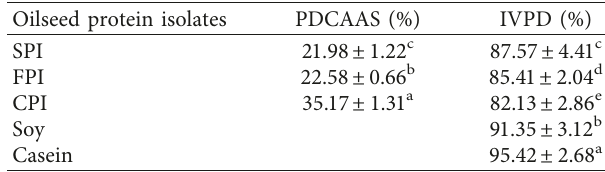
Table 4: PDCAAS and in vitro protein digestibility (IVPD) of oilseed protein isolates.